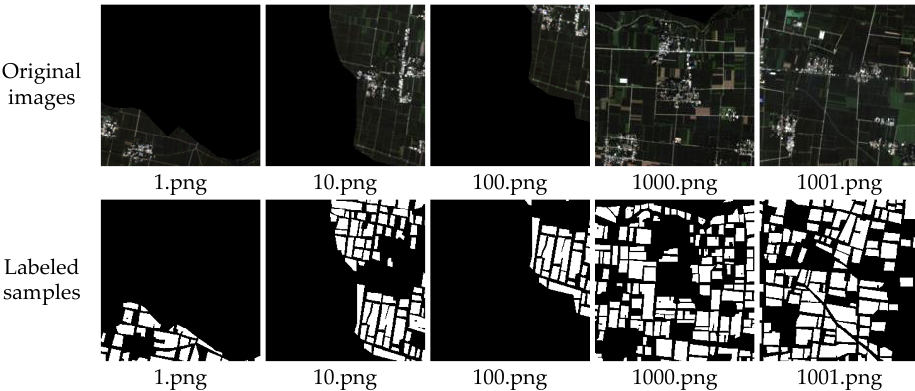
Figure 3. Original images and corresponding labeled samples.